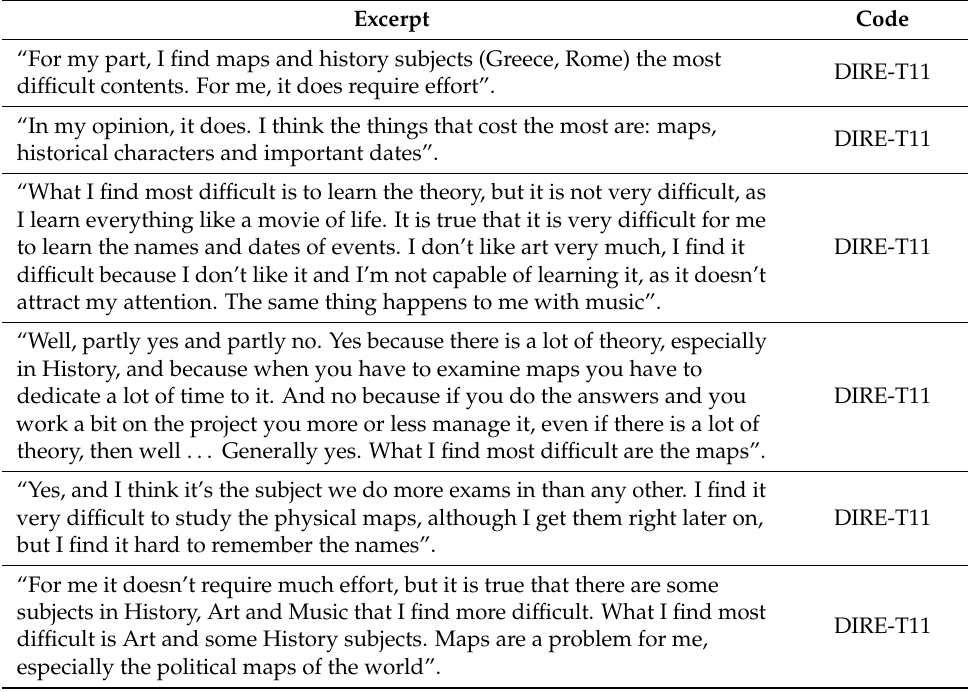
Table 7. Selection of student responses to the first interview question.